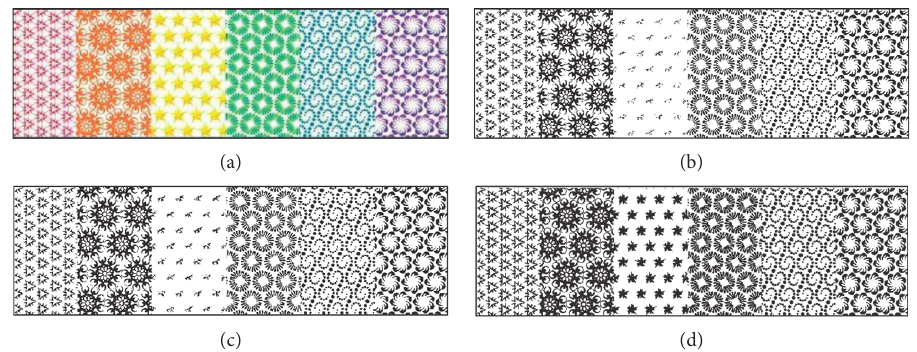
Figure 3: Segmentation result of the combination pattern. (a) Original image; (b) 1D maximum entropy t � 168; (d) 3D maximum entropy t t 2